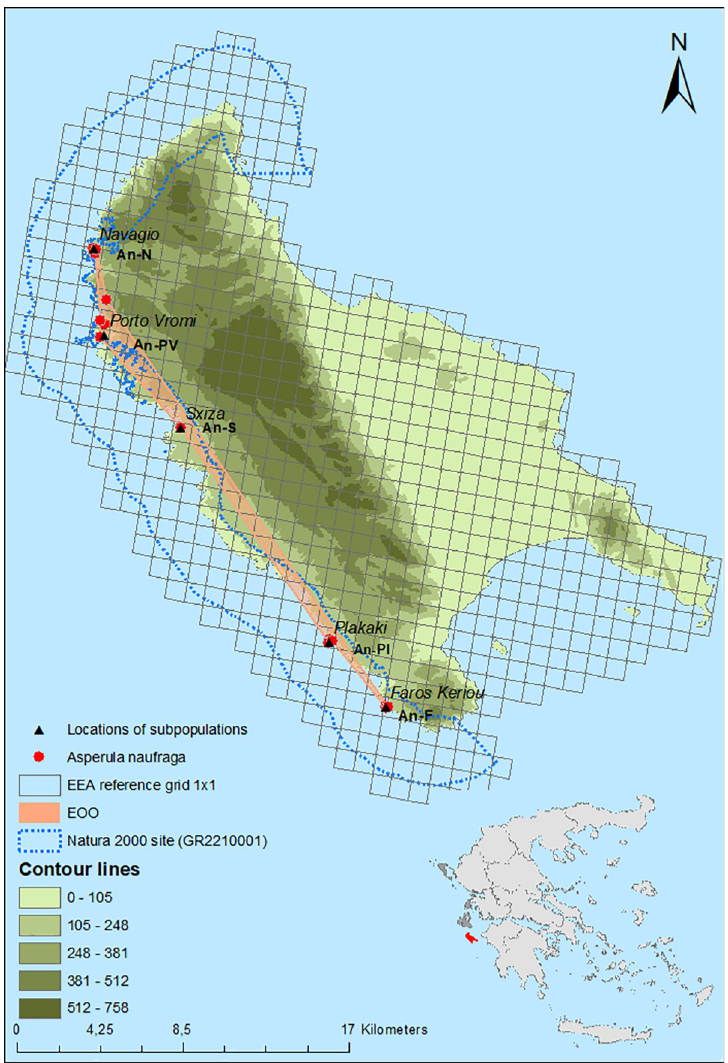
Fig 1. Geographical distribution of Asperula naufraga subpopulations (red dots) in Zakynthos Island, the estimated Extent of Occurrence (EOO), and Area of Occupancy (AOO) based on the European Environment Agency (EEA) reference grid 1 × 1 km. The data were obtained from a GPS device during field work and the map was constructed using the ArcGIS 10.5.1 (ESRI) software package.